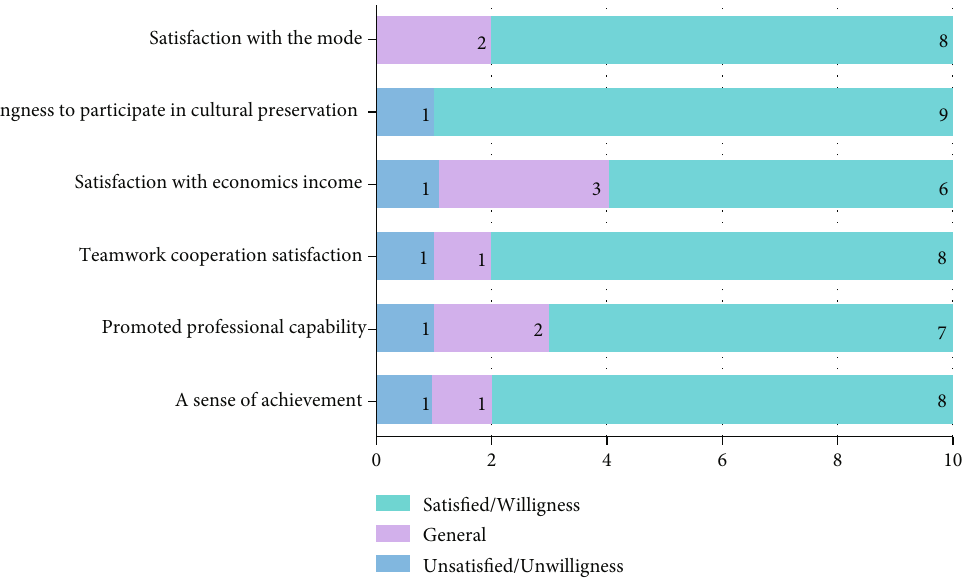
Figure 6: Professionals ’ feeling, satisfaction, and willingness of participating in the Mt. Mogan virtual